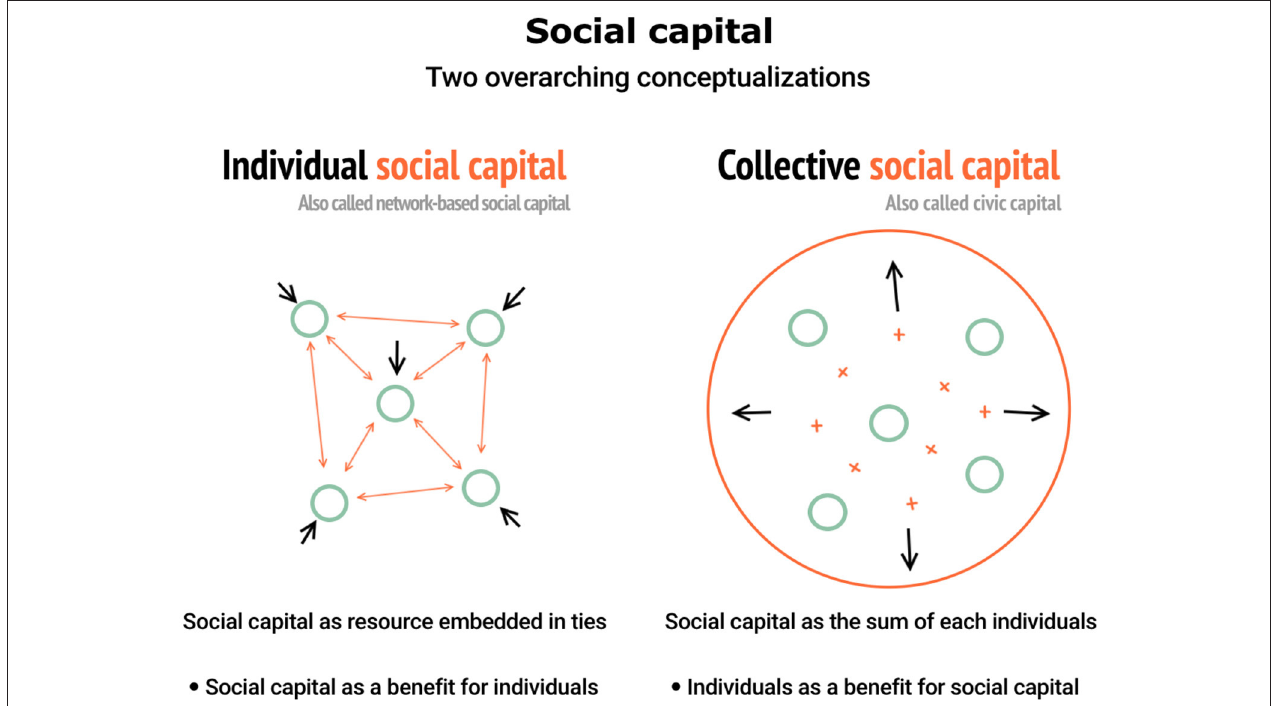
FIGURE 1 | Two overarching conceptualizations of social capital (Coppe et al., 2021). In the individual social capital perspective, social capital are the resources that individual’s access through their networks. In the collective social capital perspective, social capital is the common benefit (culture, norm,…) that is shaped by the sum of the individuals’